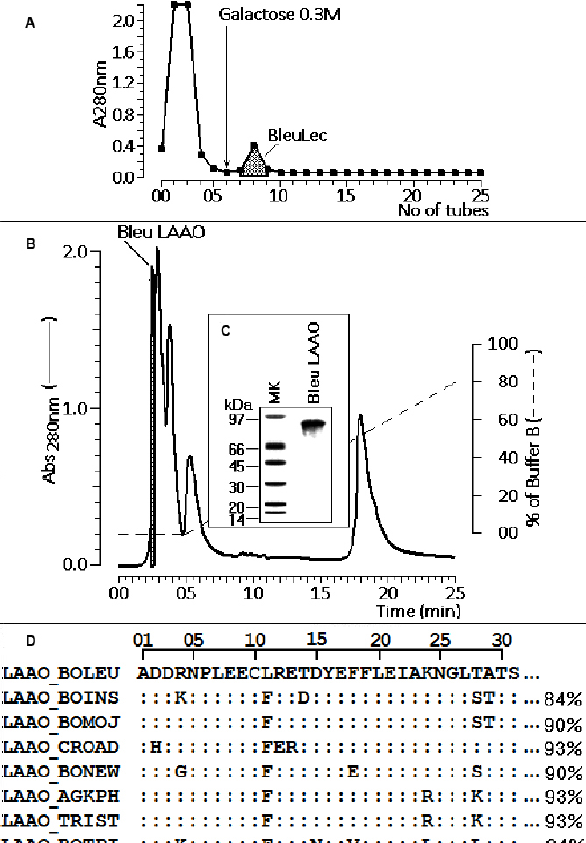
Figure 1. ( A ) The chromatographic profile of the fractionation of whole venom by lectin affinity chromatography; the non-binding sample was eluted using only TBS buffer, and lectin was eluted using TBS with galactose. ( B ) The chromatographic profile of the fractionation of LAAO from B. leucurus . ( C ) Tricine SDS-PAGE analysis of BleuLAAO. ( D ) The N-terminal sequence of this LAAO compared with other LAAO isoforms (LAAO_BOLEU: LAAO from B. leucurus ; LAAO_BOINS: LAAO from B. insularis ; LAAO_BOMOJ: LAAO from B. moojeni ; LAAO_ CROAD: LAAO from C. adamanteus ; LAAO_BONEW: LAAO from B. neuwiedi ; LAAO_AGKPH: LAAO from Agkistrodon piscivorus ; LAAO_TRIST: LAAO from Trimeresurus stejnegeri ; LAAO_BOTPI: LAAO from Bothrops pirajai ).